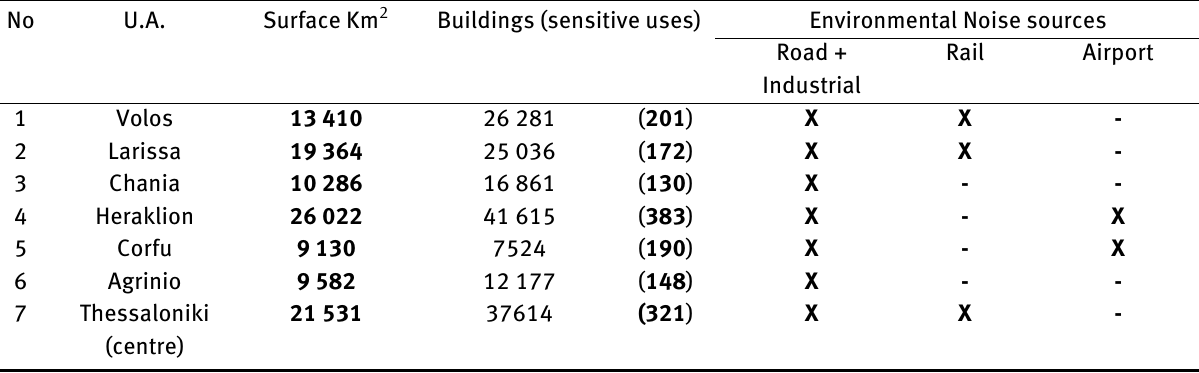
Table 1: General description of the 7 Greek urban agglomerations (U.A.).